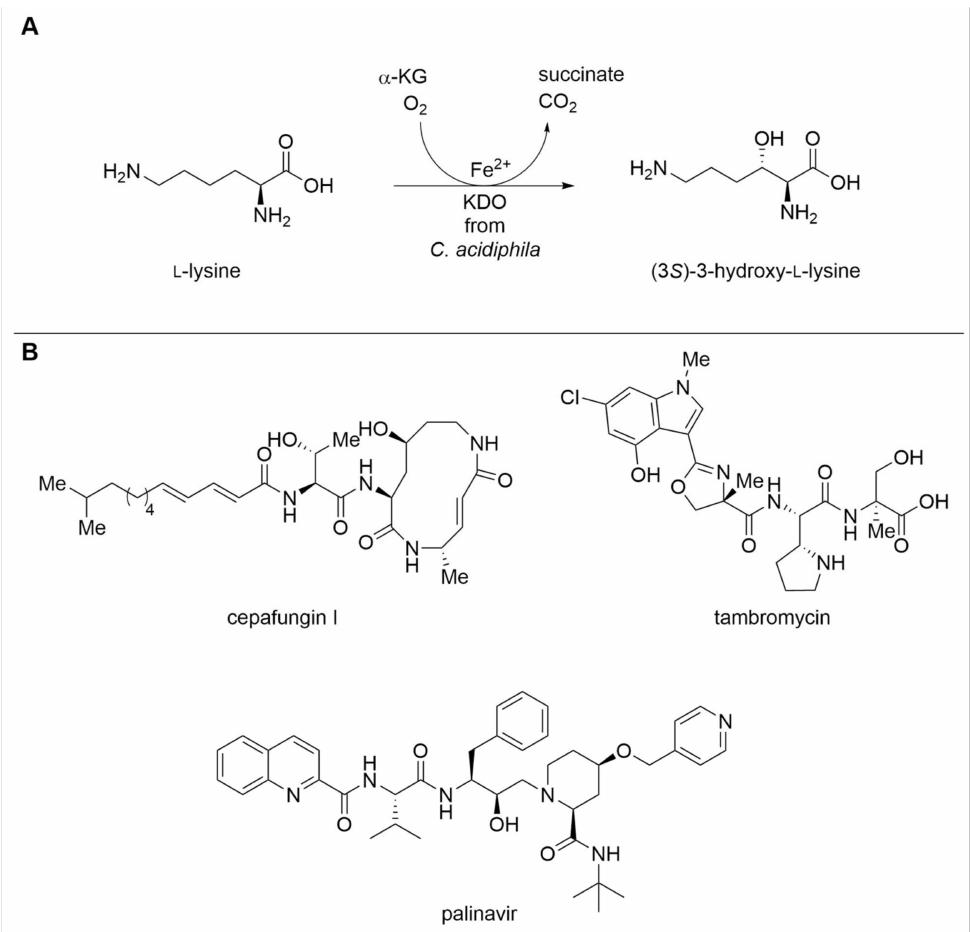
Figure 4. ( A ) Biocatalytic reaction of the KDO from Catenulispora acidiphila [39]. ( B ) Molecules of pharmacological interest with chiral hydroxy- L -lysine as building block. α -KG, α